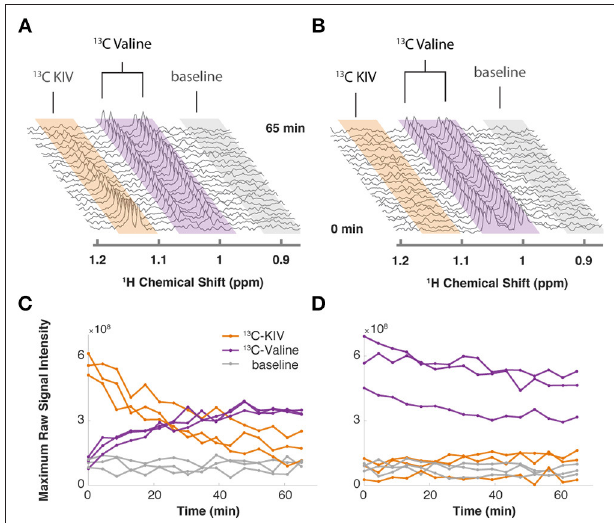
FIGURE 1 | Targeted isotopic CIVM-NMR measurement of metabolic flux in human myeloid leukemia cells. (A) 13 C-labeled keto-isovalerate (KIV) was converted to valine. (B) 13 C-labeled valine was not converted to KIV, confirming unidirectional flux in ML cells. (C,D) Relative concentrations over time of 13 C-labeled KIV (orange) and 13 C-labeled valine (purple) compared to baseline noise (gray), obtained by taking the raw maximum spectral intensity within each region of the representative experiments in (A , B) , respectively. Different lines show the data from 3 independent replicates of each